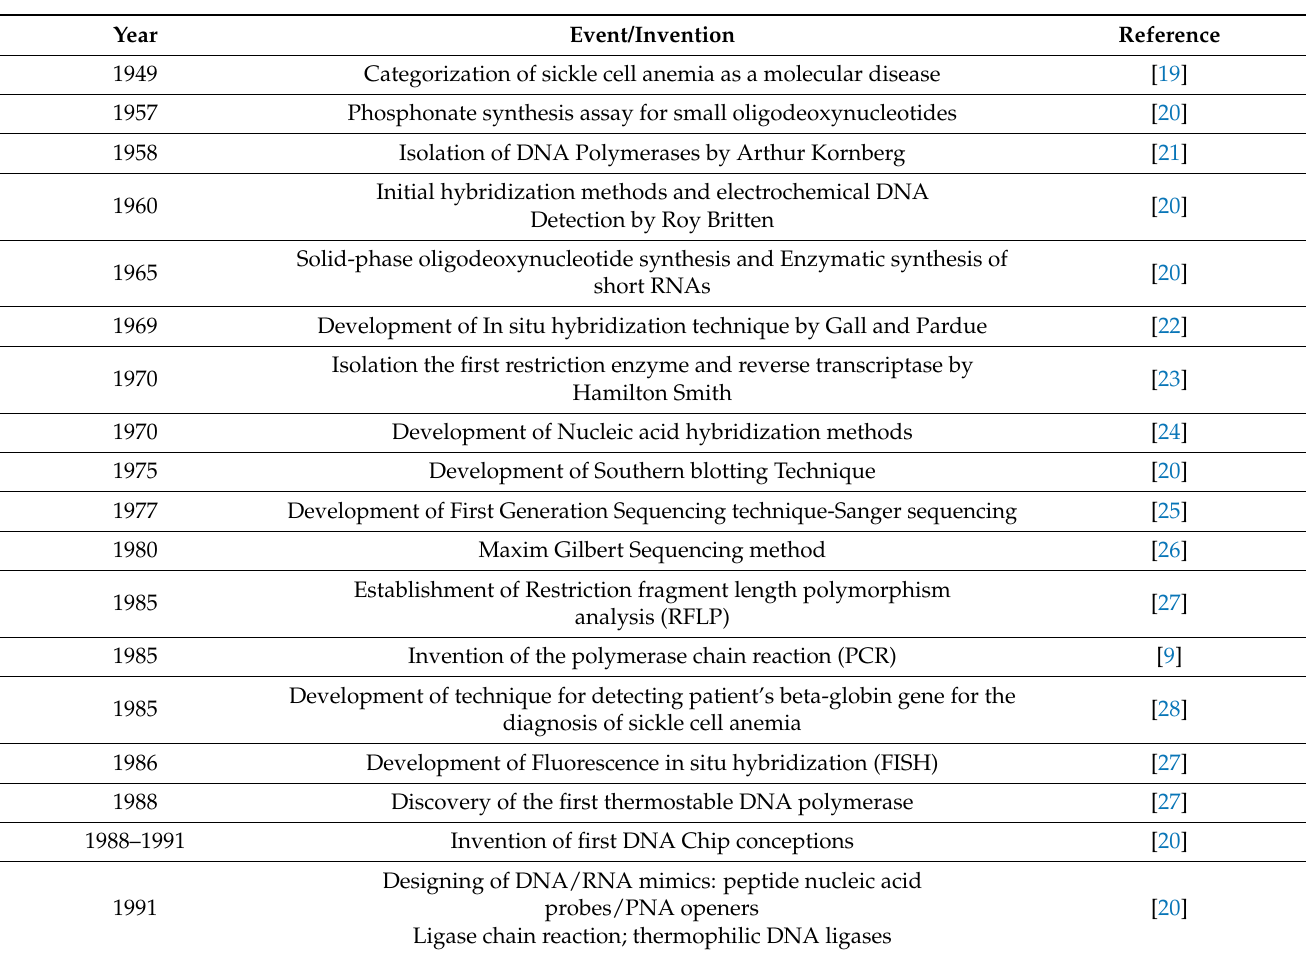
Table 1. Timeline of events and techniques in molecular